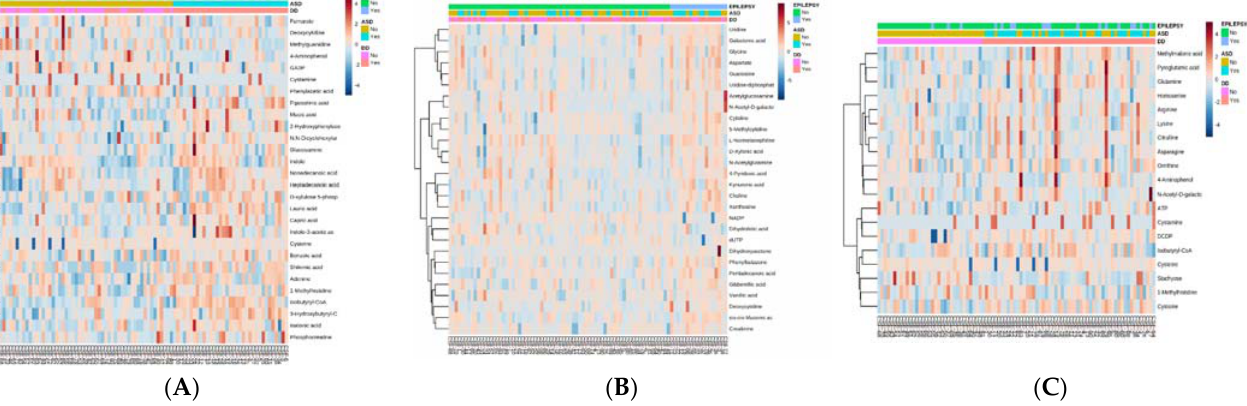
Figure 1. Heatmaps for Metabolites Found to Be Significantly ( p ≤ 0.05) Related to Specific Clinical Groups. Each map is sorted by clinical group with color key for group membership on top of heatmap. Heatmap color represents ( A ) ASD (28 significant features); ( B ) epilepsy (28 significant features); ( C ) DD (19 significant features).